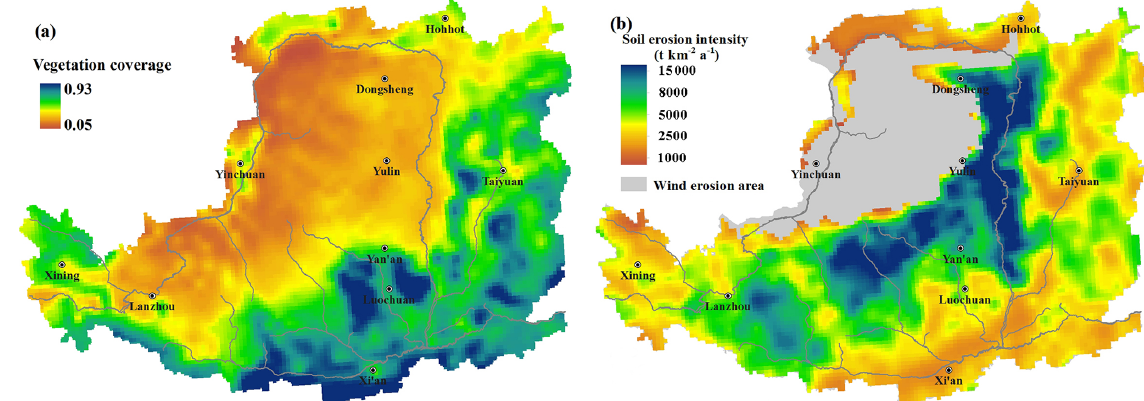
Figure 7. (a) Spatial distribution of mean vegetation coverage in summer (from June to August) on the Loess Plateau from 1982 to 2006 at a spatial resolution of 8km. (b) Spatial distribution of the soil erosion intensity, which was resampled to a spatial resolution of